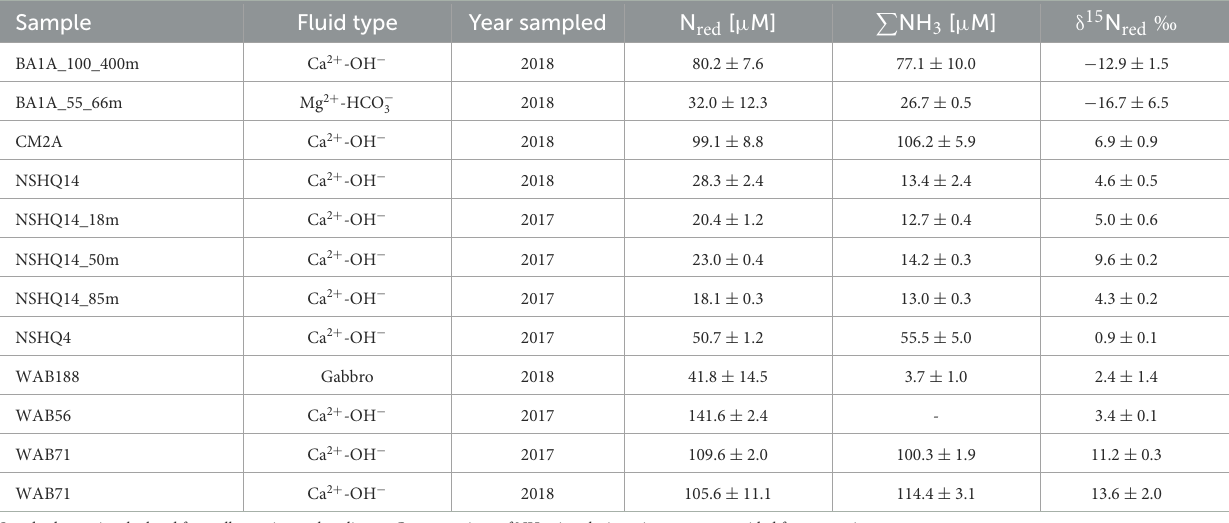
TABLE 3 δ 15 N of N red which represents the total reduced nitrogen in the sampled fluid (measured by the denitrifier method through mass balance after persulfate oxidation). Sample